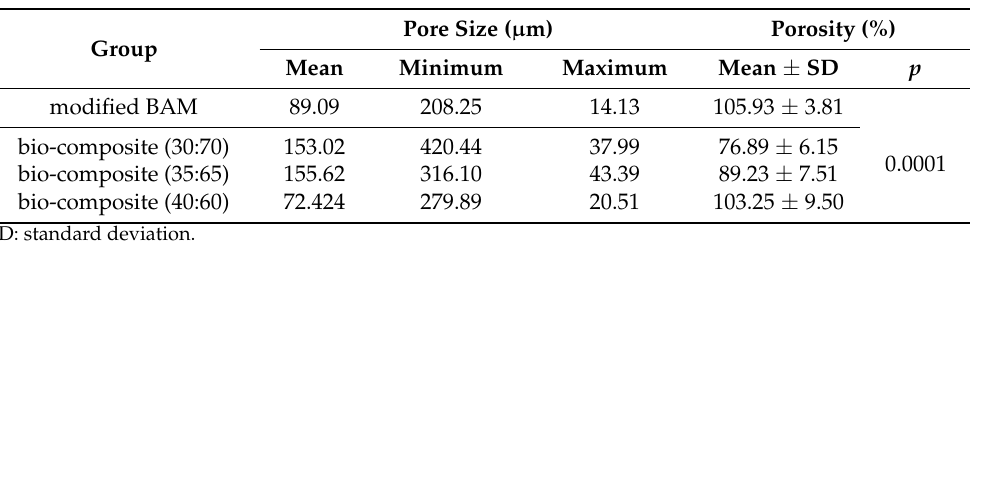
Figure 4. The surface and porosity analysis using SEM with 100× magnification. ( a ) Modified BAM; ( b ) bio-composite (30:70); ( c ) bio-composite (35:65); ( d ) bio-composite (40:60).